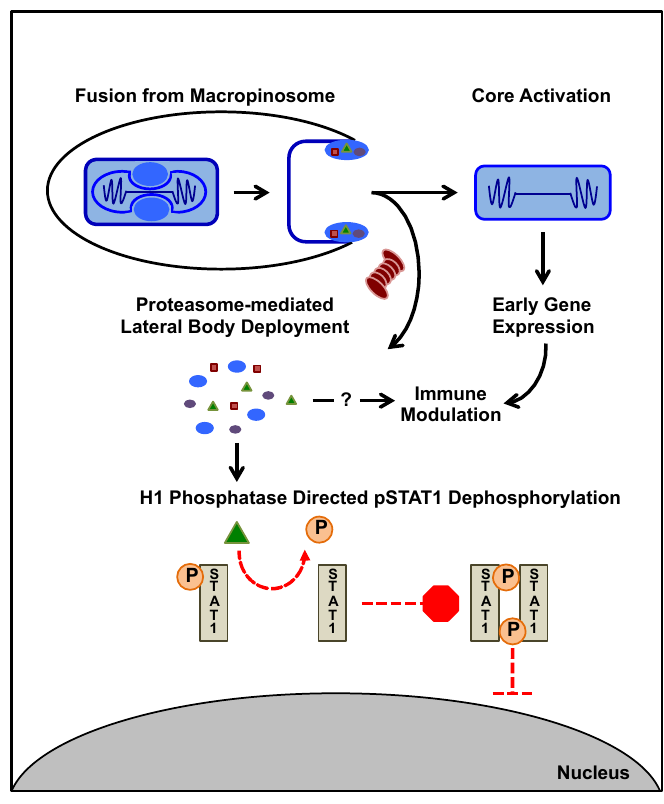
Figure 2. VACV LBs as Immunomodulatory Delivery Packets. After internalisation via macropinocytosis VACV particles undergo fusion with the limiting membrane of the macropinosome releasing the viral core into the cytoplasm. The released viral cores are “activated” as indicated by morphological changes and the initiation of early gene expression from within. Upon fusion, the LBs detach from the core and remain associated with the viral membrane. Once exposed to the cytoplasm, LBs are rapidly disassembled, with the major LB structural protein, F17, undergoing proteasome dependent degradation. Disassembly of the LB appears to facilitate release of other LB proteins and, in the case of the viral dual specificity phosphatase H1, is required for their action. Release of H1 from LBs, serves to shunt cellular antiviral transcription prior to the expression of early viral genes. To do this, H1 dephosphorylates phospho-STAT1 preventing its homodimerisation and nuclear translocation. To date only three LB components F17, H1, and a viral disulfide oxidoreductase G4 have been identified.